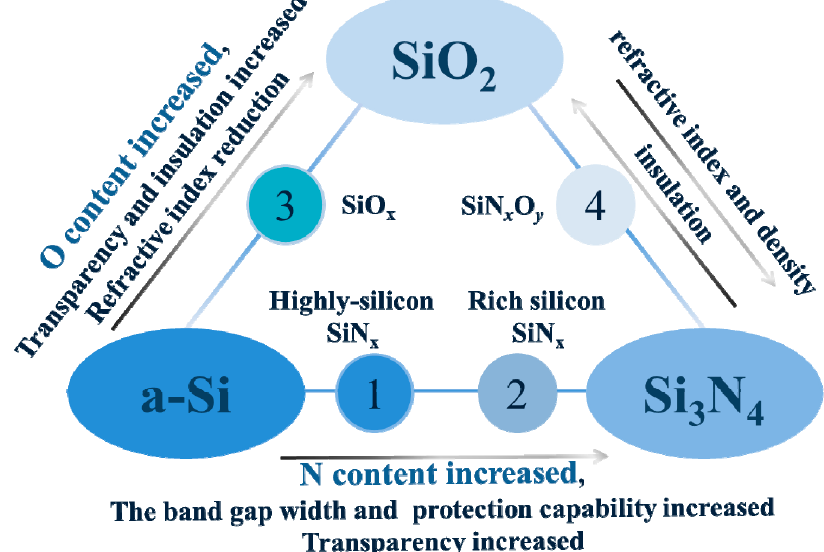
Figure 4. A series of possible forms of the SiN x O y film and their performance.